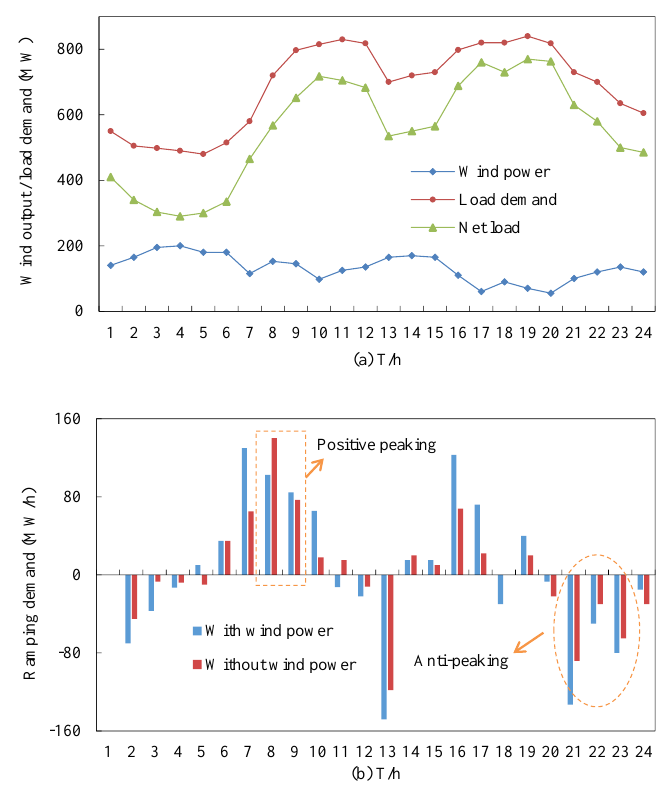
Figure 1. Load demand/wind output under four seasons; ( a ) net load fluctuation with and without wind power integration; and, ( b ) ramping demand of systems with and without wind power.